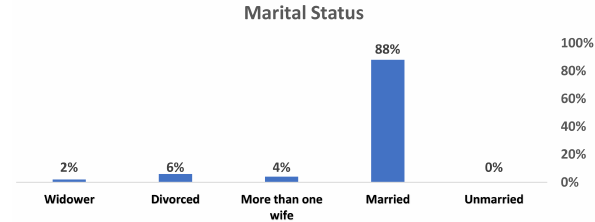
Fig. 1. The marital status of the sexually active participants. Out of 250 sexually active respondents, 88% were married, 4% have more than one wife while 6% and 2% were divorced and widowers